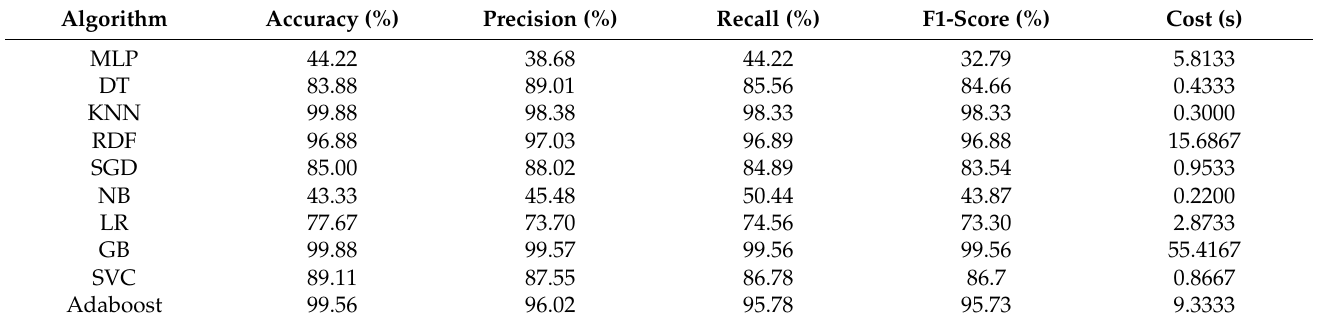
Table 14. Global performance comparison of ML models using combination of (Q) and (D) features.